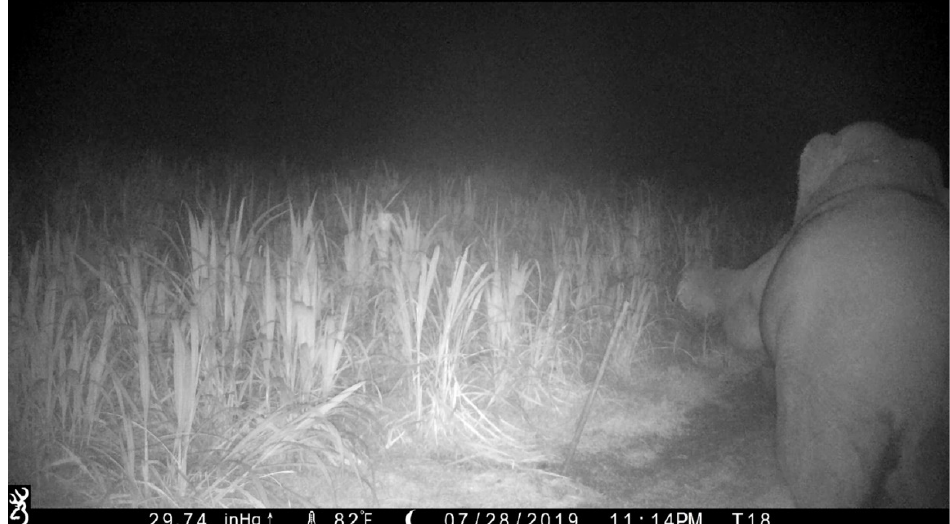
Figure 1. A still from a camera trap video taken along the periphery of a crop field in Thailand. The bull elephant is using his foot to snap the wire of an electric fence in order to enter a sugar cane field. The elephant regularly forages in this field at night, suggesting he uses olfactory information to locate the sugar cane. Video recorded by the